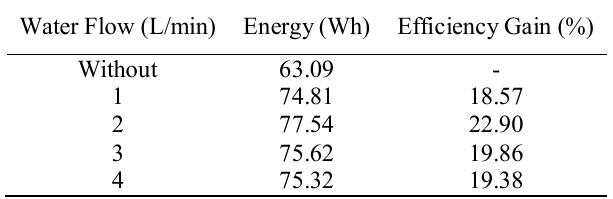
TABLE II E FFICIENCY GAIN OF THE PV PANEL WITH THE COOLING SYSTEM ..